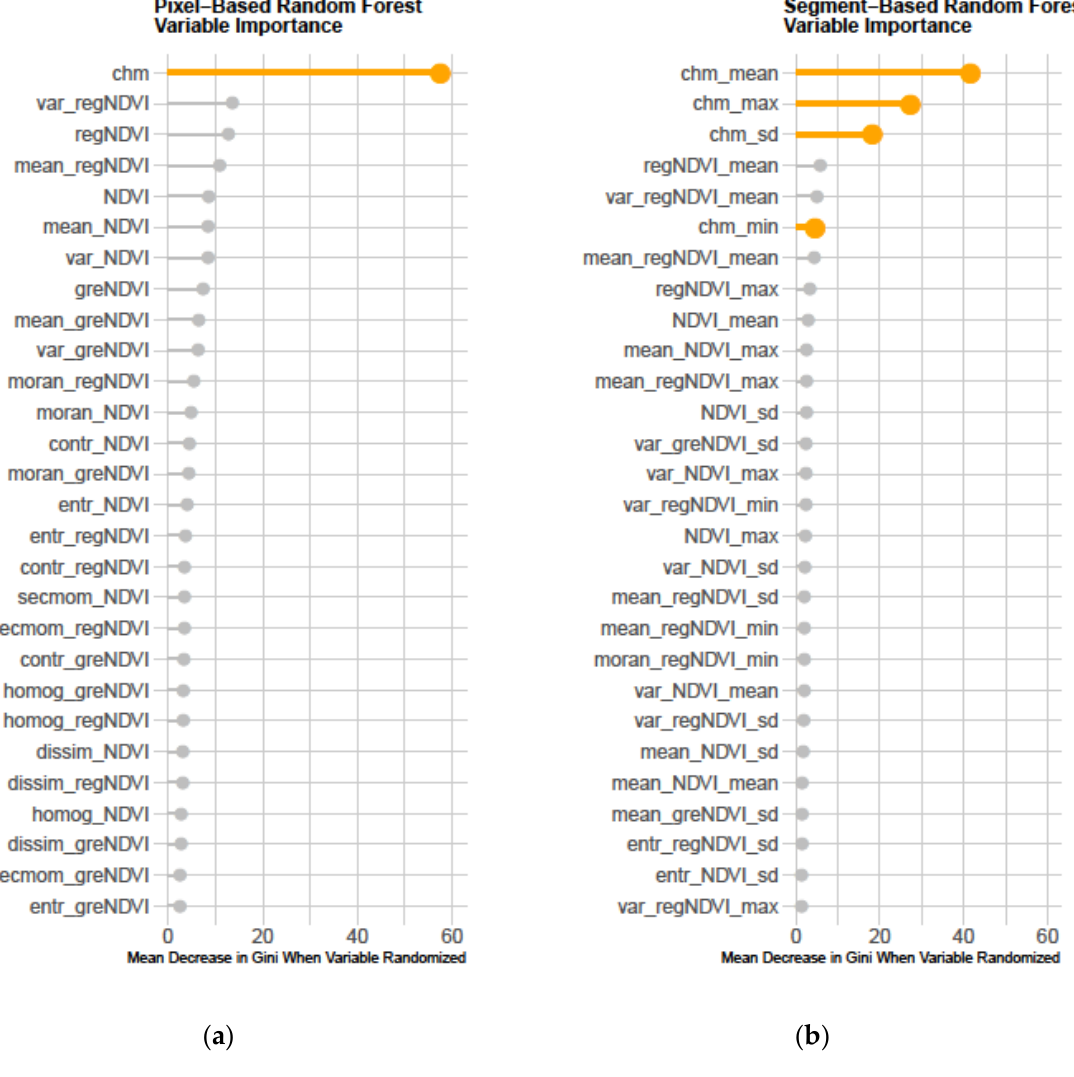
Figure 3. Variable importance for ( a ) pixel- and ( b ) segmented object-based RF models. Numbers represent the decrease in sorting efficiency measured by the Gini index when each variable is individually reshuffled and classes are re-predicted (we present all 28 covariates for P-RF, but the top 28 of 112 covariates for S-RF). Structural variables from the CHM are noted in orange.